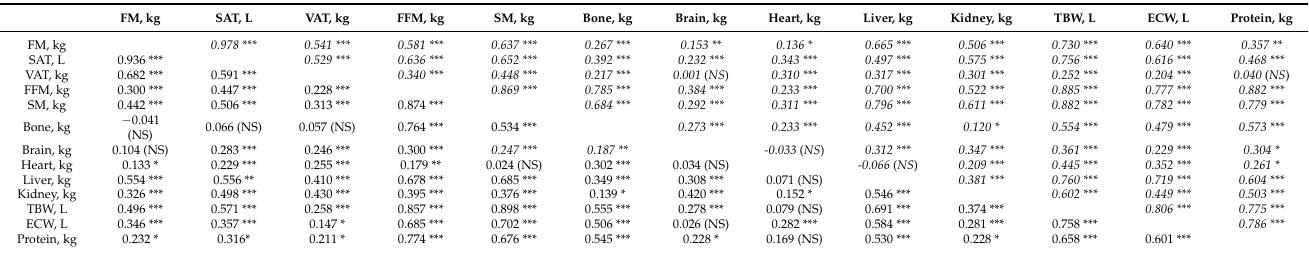
Table 2. Cross-correlation matrix of body components, organs tissues in females (italic) and males (normal) of the ‘Kiel study population’ (see Methods for further